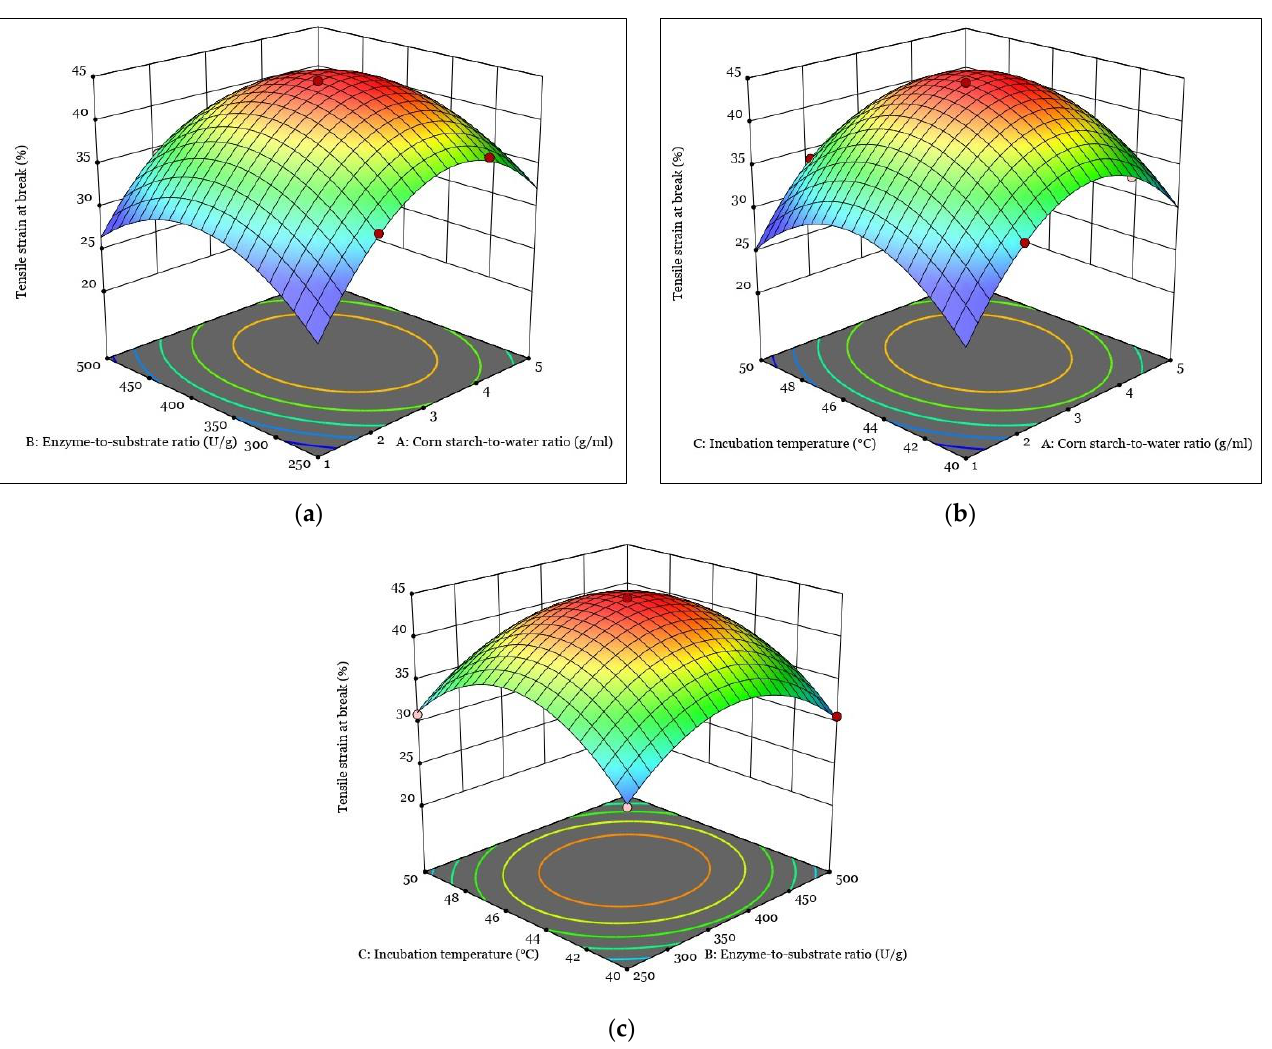
en A and C; ( c ) interaction between B and C.